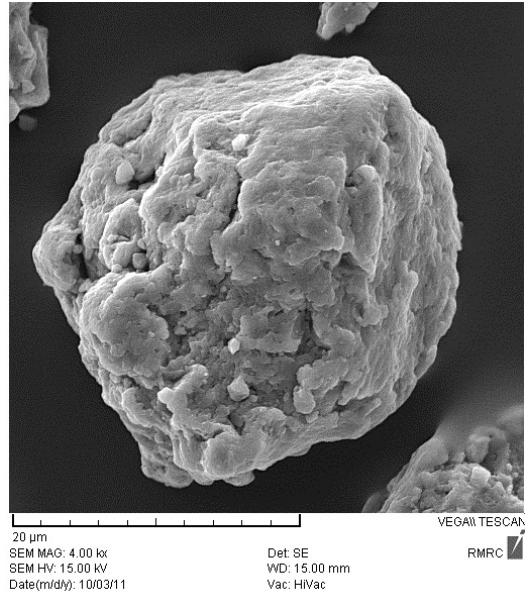
Figure 2. SEM image of semi-globular particle of Al-5 wt %Si formed after 50 h of milling.